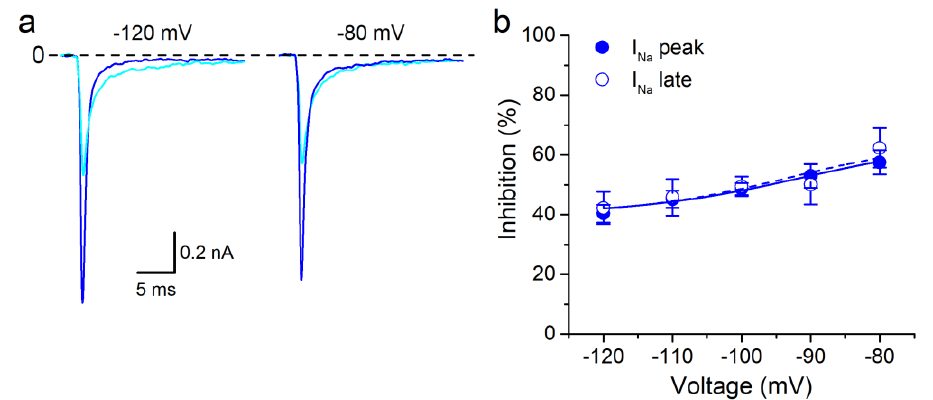
Figure 5. The effect of HSP on I Na in the ∆KPQ mutant channels is poorly dependent on the holding potential. ( a ) Effects of HSP (300 µM) on I Na evoked at −20 mV from two different holding potentials (HP). Decreasing the HP from −120 mV to −80 mV, barely increased the block of I Na by HSP. ( b ) Boltzmann functions describing the HP dependency of HSP (300 µM) effect on peak I Na and late I Na in ∆KPQ hNa V 1.5 channel. The dots represent the mean ± s.e.m. ( n = 7). The inhibitory effect of HSP is barely dependent on the holding potential in ΔKPQ channels.